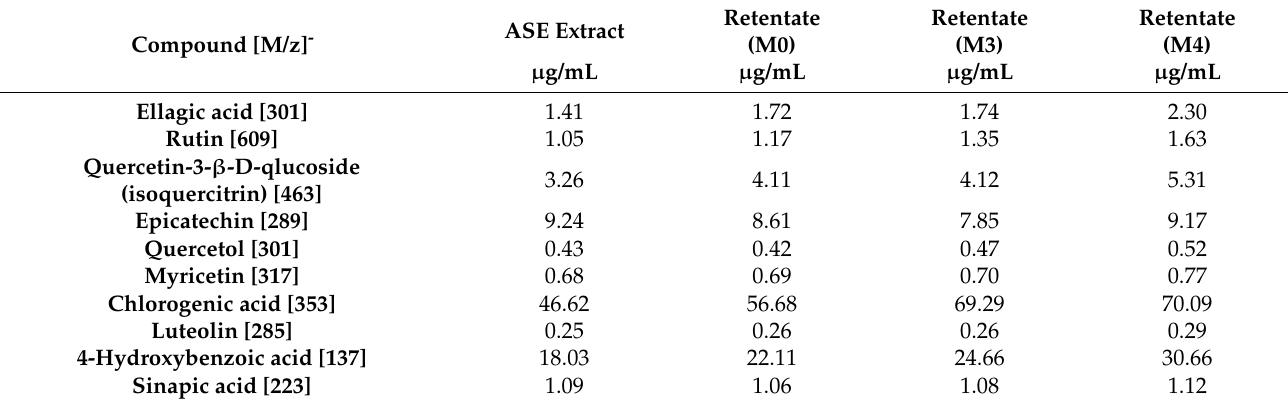
Table 3. HPLC-MS analysis results for ASE extract and retentate fractions.